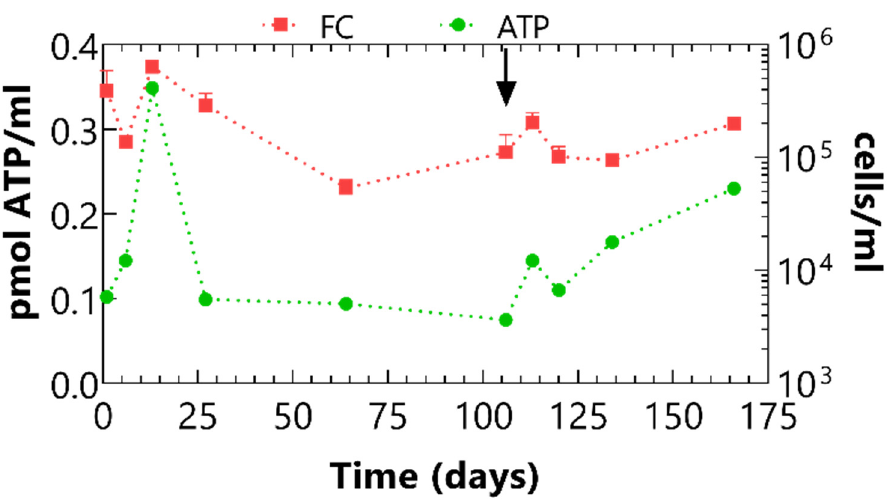
Figure 9. Intracellular ATP measurements (green) representative of microbial activity and total cell concentration based on flow cytometry (red) during the in situ test. ATP measurements are plotted on the left Y -axis, while flow cytometry results are plotted on the right Y -axis. The time of the second injection is indicated with an arrow.